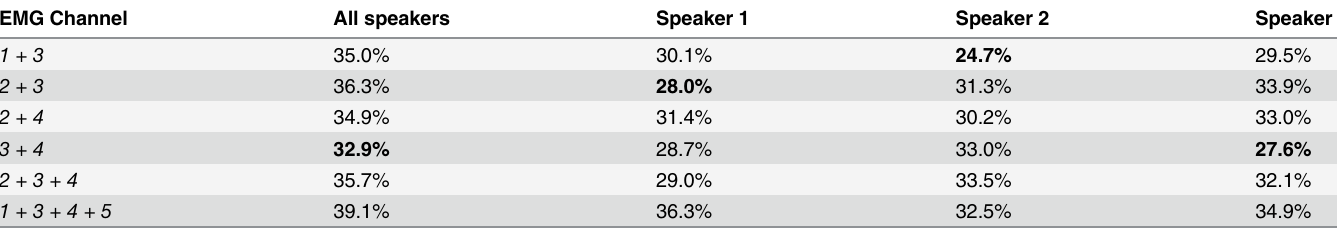
Table 4. Mean error rate using multiple channels